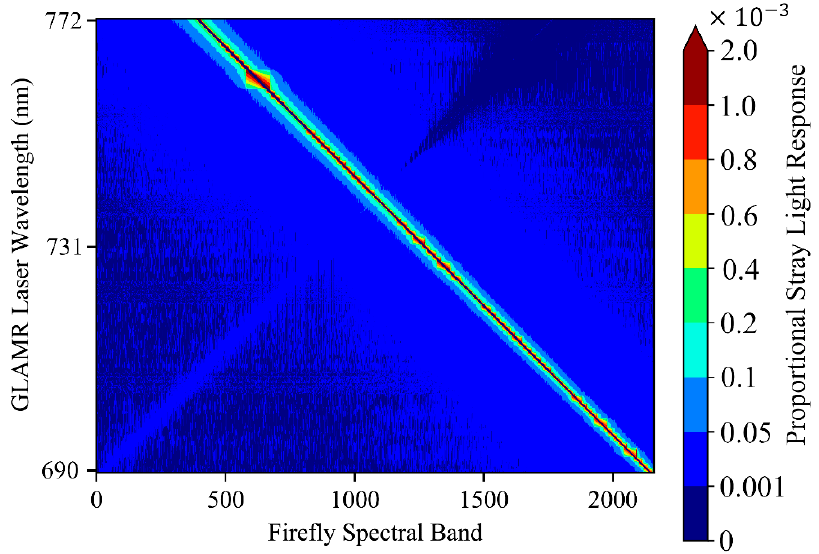
Figure 13. The proportional response of FIREFLY bands to a range of wavelengths of light emitted by the GLAMR laser. Note the non-linear, categorical color-ramp.